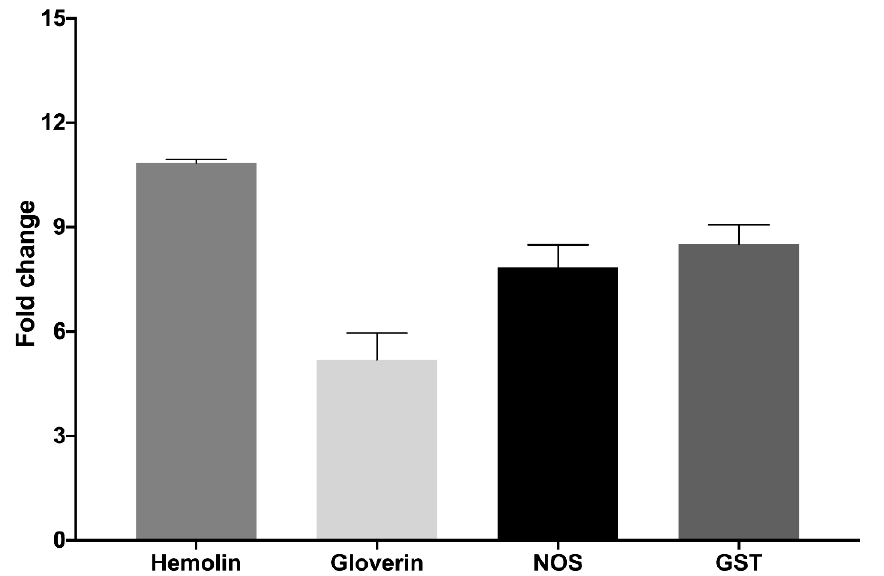
Figure 8. Fold changes in G. mellonella immune-relevant gene expression determined by qRT–PCR of hemocytes in culture stimulated with M. abscessus compared with unstimulated hemocytes. The 18S ribosomal RNA gene was used as an internal standard gene. The values shown are the average from one experiment performed in triplicate. The error bars indicate a positive standard deviation.